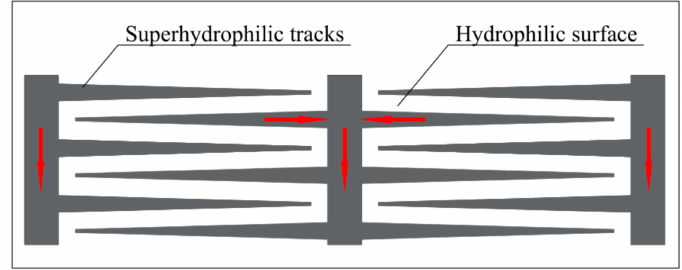
Figure 8. Periodically patterned samples for condensation experiments [74].